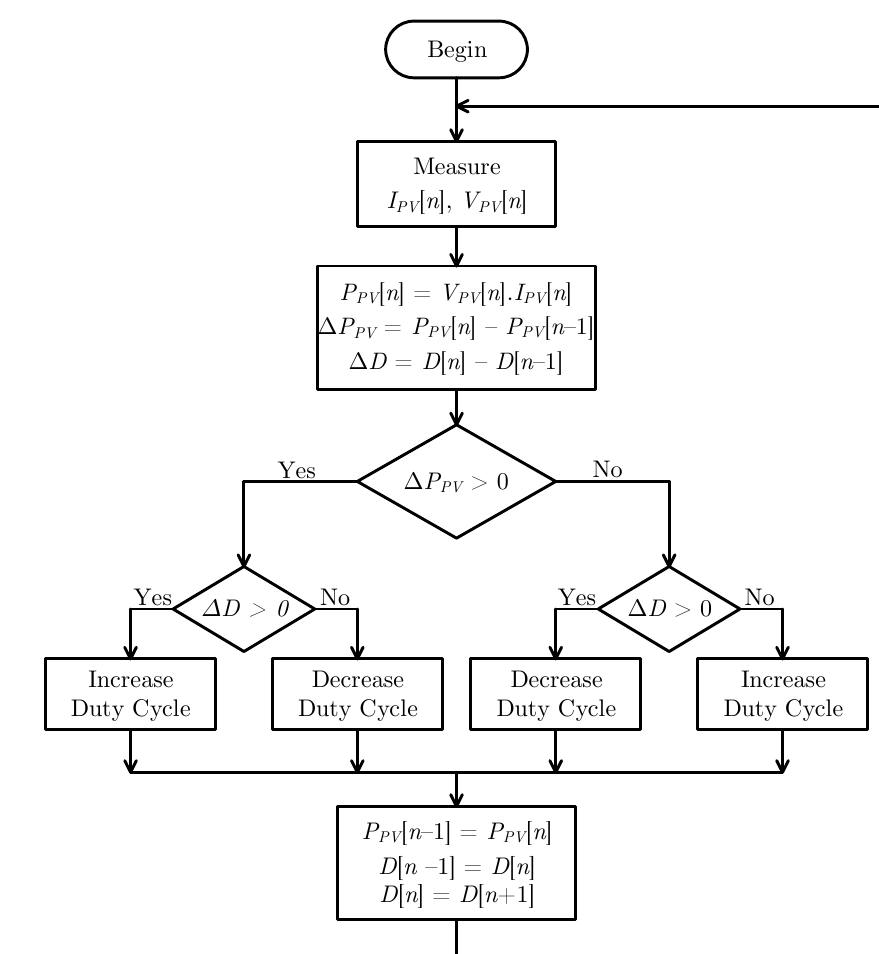
Figure 7. Hill climbing algorithm’s flowchart.